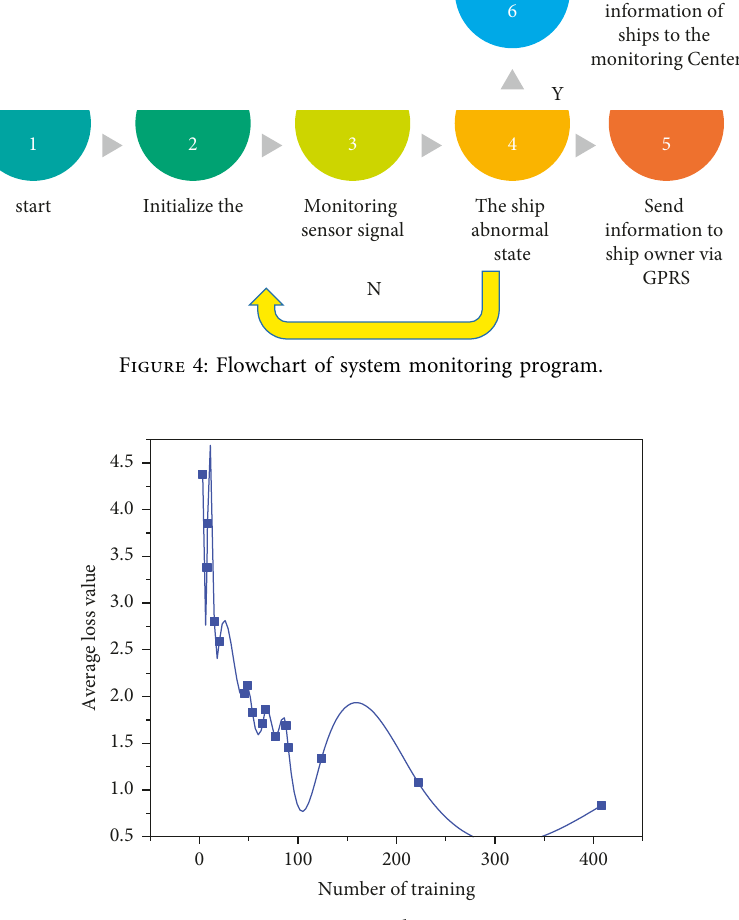
Figure 5: Average loss curve.